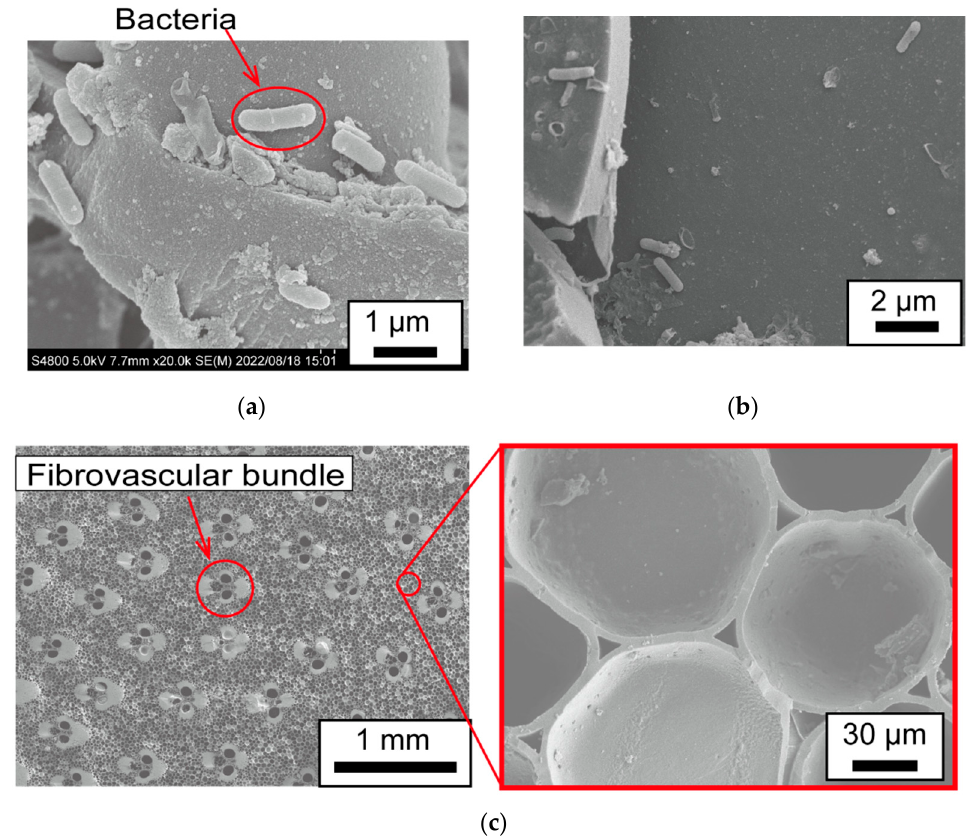
Figure 9. SEM observation results: ( a ) the bacteria on the surface of the bamboo charcoal electrode; ( b ) the interior of the bamboo electrode where there are few bacteria; and ( c ) the honeycomb structure inside the bamboo charcoal.